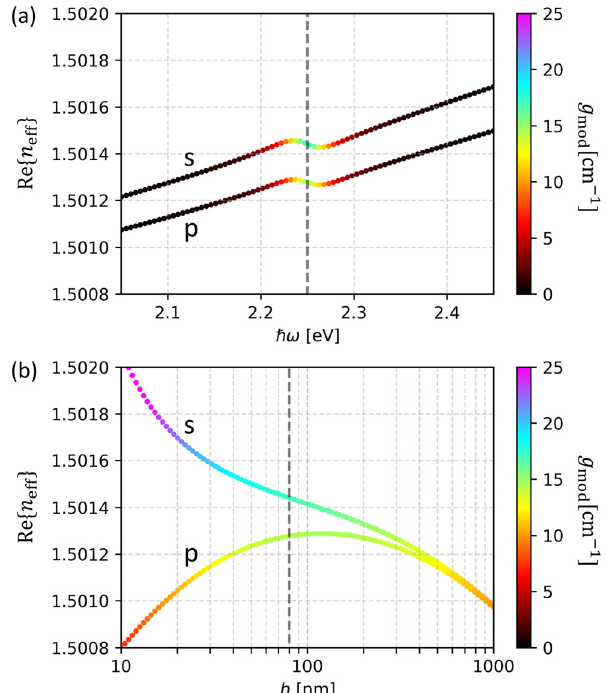
Figure 6: (a) Complex effective mode index n eff calculated using transfer matrix method, for the s- and p-polarized fundamental guided modes of a gain-doped layer that imitates the nanoparticle array from Section 2.3. The layer has permittivity ε l ≈ ε g and thick- ness h =80nmandissurroundedbyamediumofindex n d =1.5.The gray dashed line marks ℏ ω = 2.25 eV. (b) Dependence of n eff on the assumed h at a fi xed photon energy equal to ℏ ω g = 2.25 eV, with ε l governed by Eq. (6). The gray dashed line marks h = 80 nm. In both (a) and (b), modal gain coef fi cient g mod (cid:1) 2 k 0 Im { n eff } is encoded in the